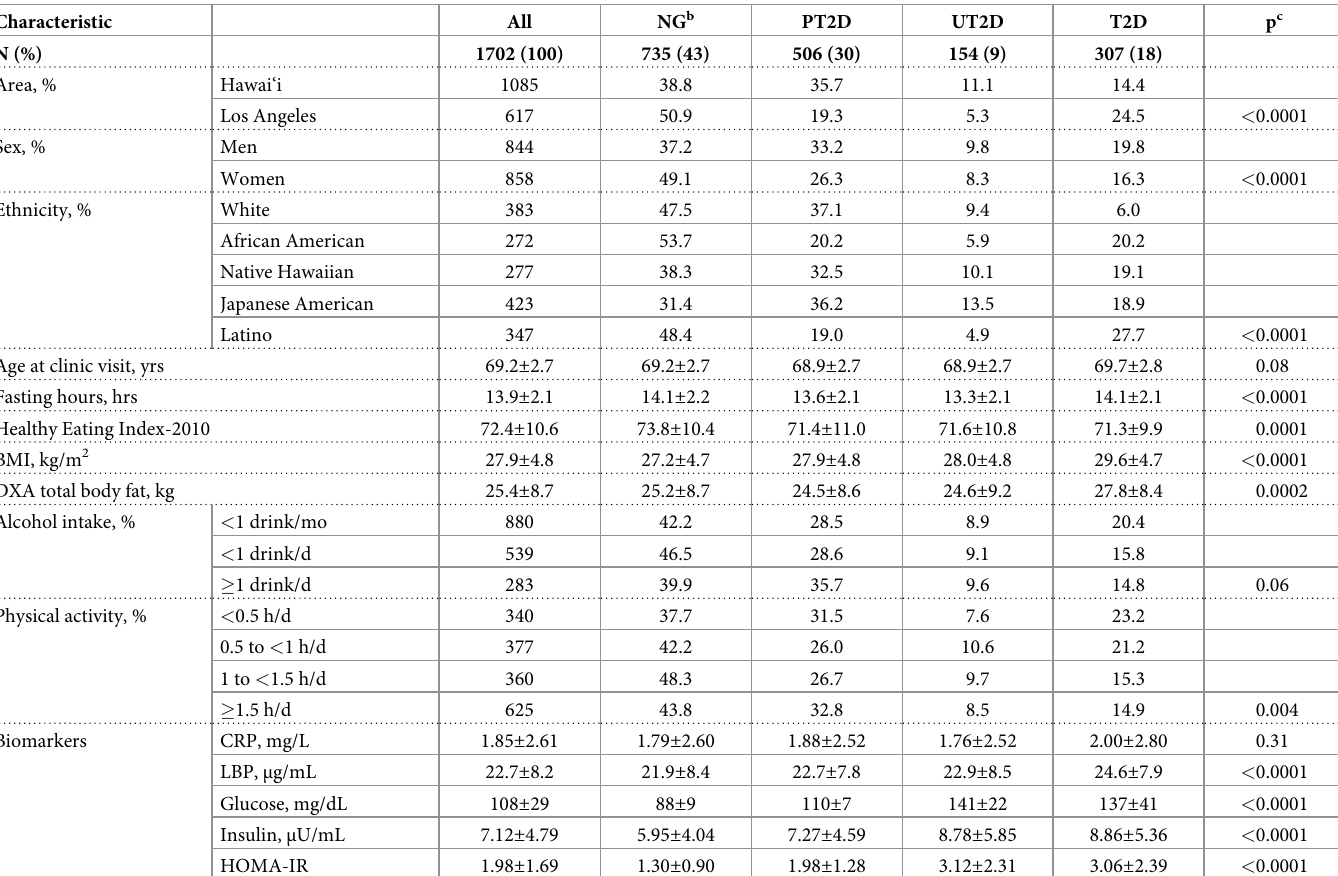
Table 1. Characteristics of the study population at clinic visit, APS, 2013–2016 a